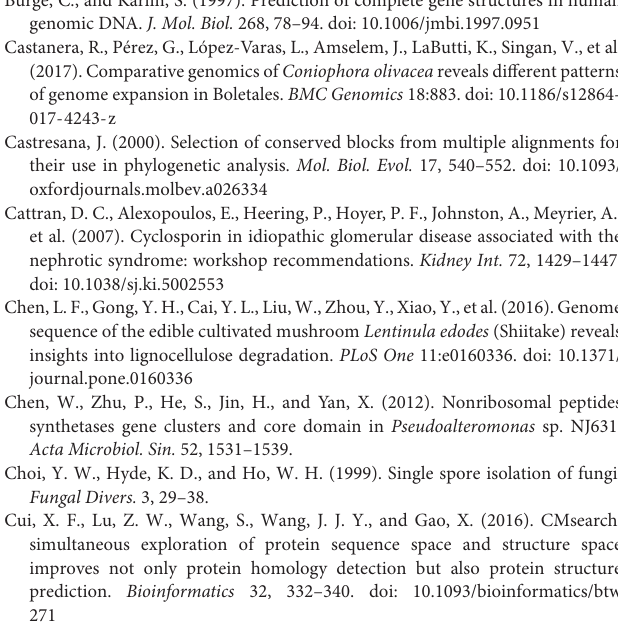
Supplementary Table 6 | Distribution of the CAZyme family genes in different